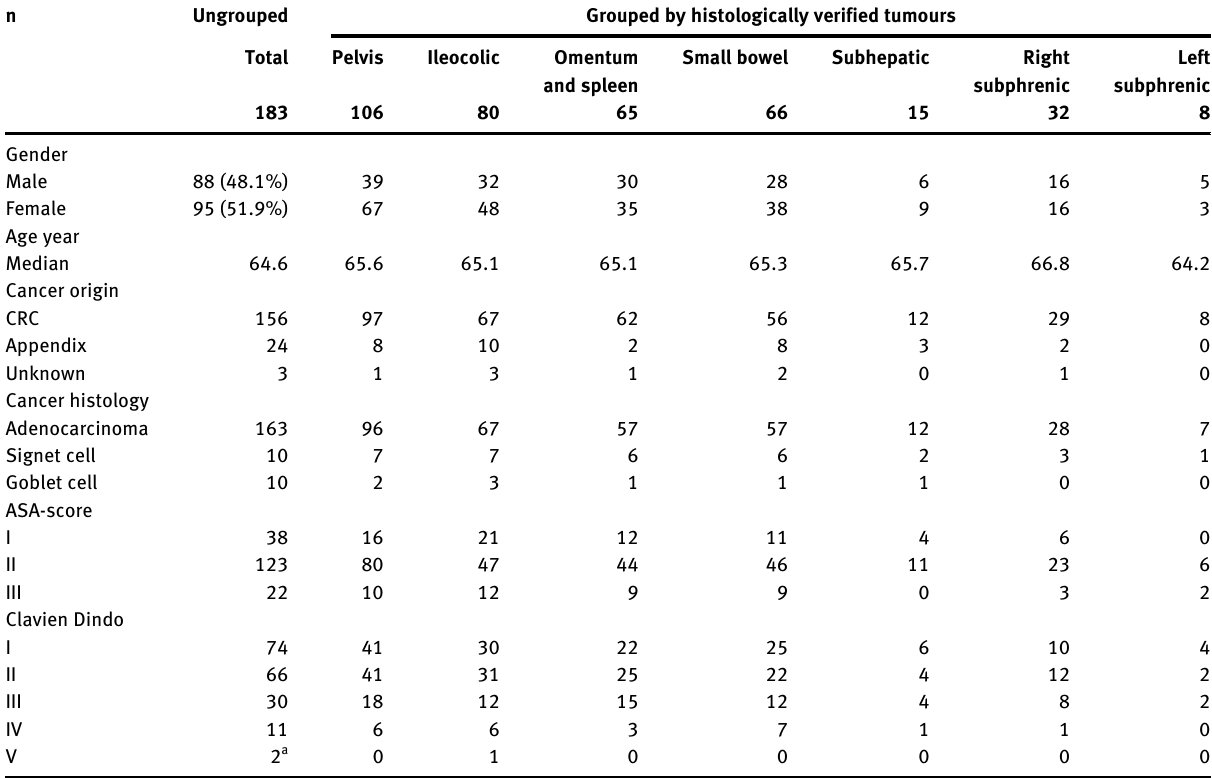
Table  : Patient characteristics: Total and grouped by abdominal region with histologically veri fi ed tumours. n Ungrouped